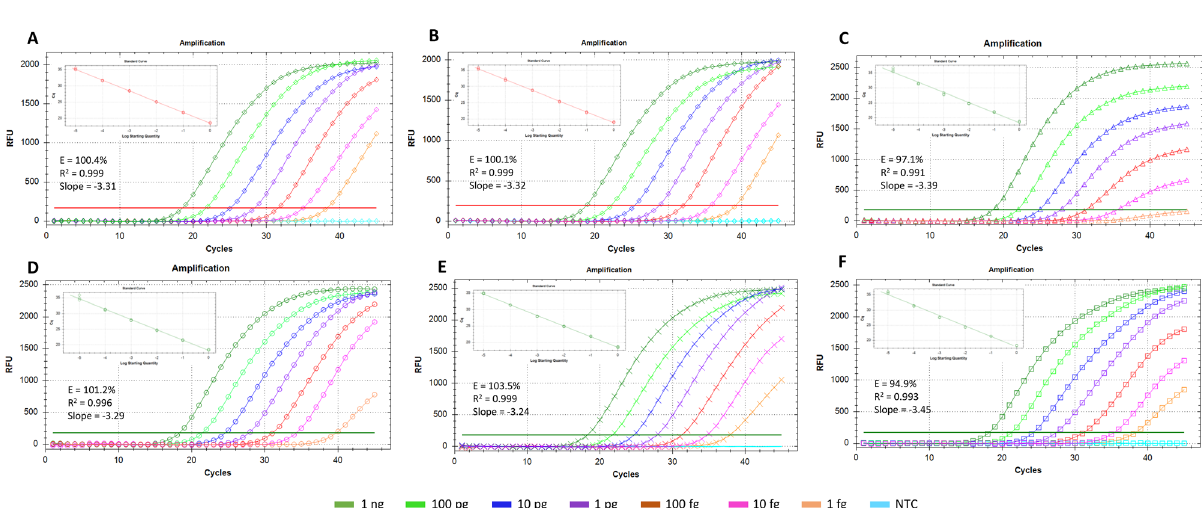
Figure 4. TaqMan real-time qPCR-based sensitivity assays with and without internal controls to predict detection limit of Rathayibacter toxicus . Qiagen Rotor-Gene Multiplex PCR Master Mix was used for these sensitivity assays. ( A ) R. toxicus detection + No AIC; ( B ) R. toxicus detection spiked with 1 ng host DNA + No AIC; ( C ) R. toxicus detection + AIC-1 + No additional primer set was added (only R. toxicus specific primers were used); ( D ) R. toxicus detection + HIC with host DNA + No AIC; ( E ) R. toxicus detection + AIC-2 + HIC but no host DNA; ( F ) R. toxicus detection + AIC-2 + HIC with host DNA. Dilution color codes are provided at the bottom of the figure; NTC is non-template control